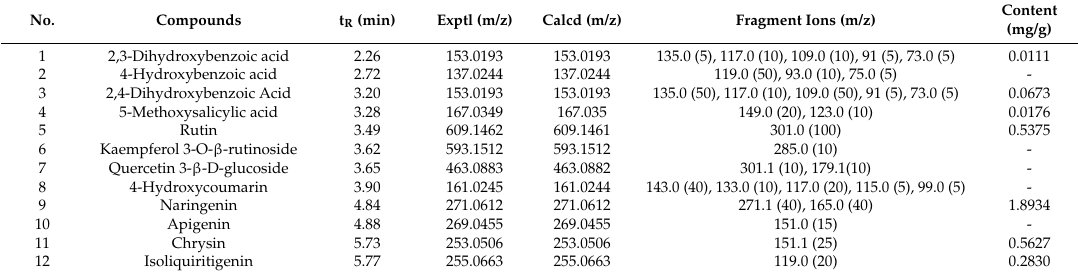
Table 1. Characterization of the 12 compounds of SCPE by UHPLC-Q-Orbitrap-HRMS.